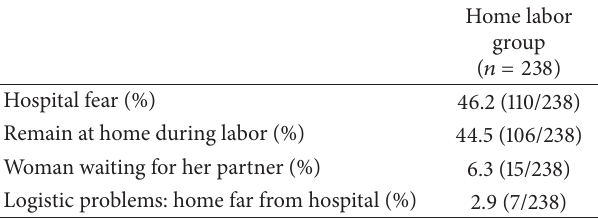
Table 4: Grounds for late hospital admissions in the study